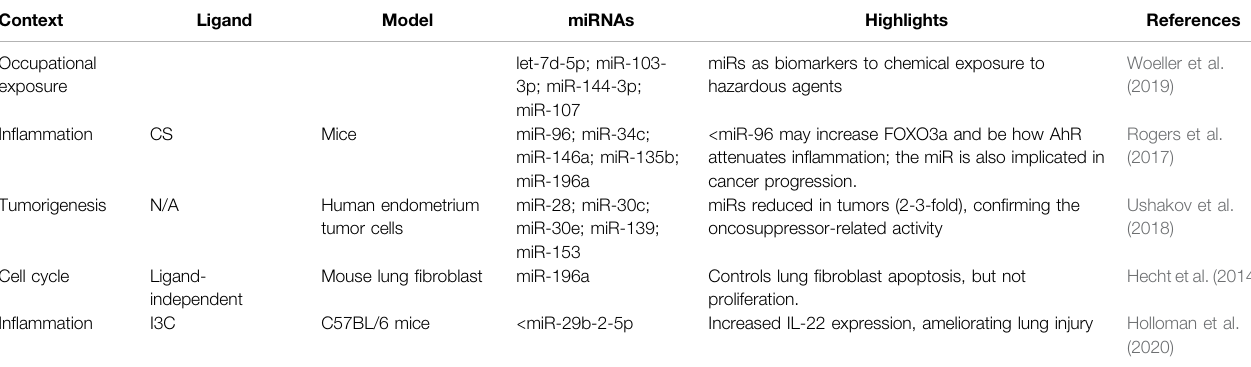
TABLE 1 | ( Continued ) Summary of the reviewed papers examining AhR-miRNA axis mutual regulation